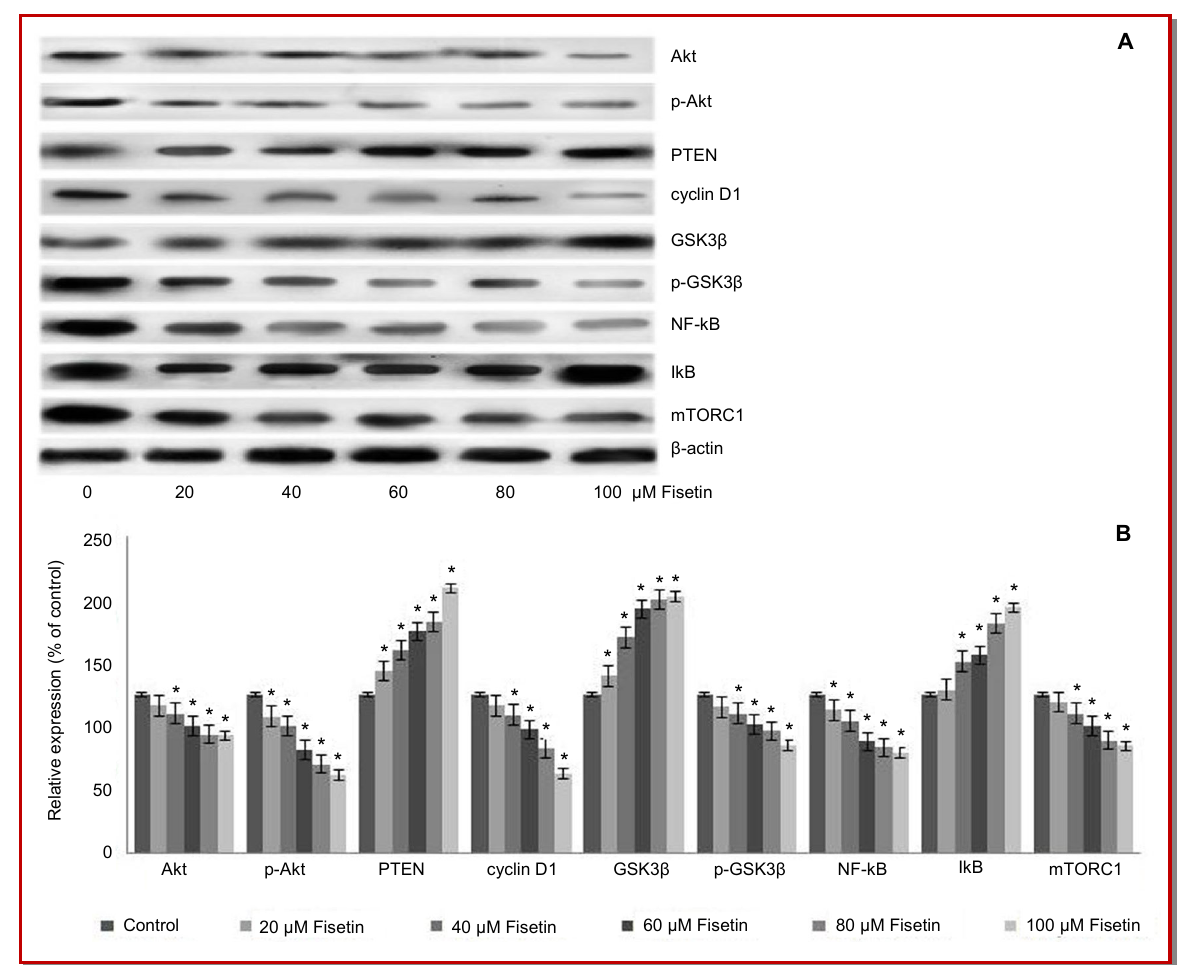
Figure 5: Fisetin regulates the expression of PI3K/Akt pathway proteins (A) Fisetin effectively modulates the expressions of the PI3K/Akt signalling proteins. Fisetin dose-dependently inhibits the pathway. (B) Relative expressions of the PI3K/Akt pathway proteins. Values are represented as mean ± SD; n=3; *represents p<0.05 compared with control as determined by one-way